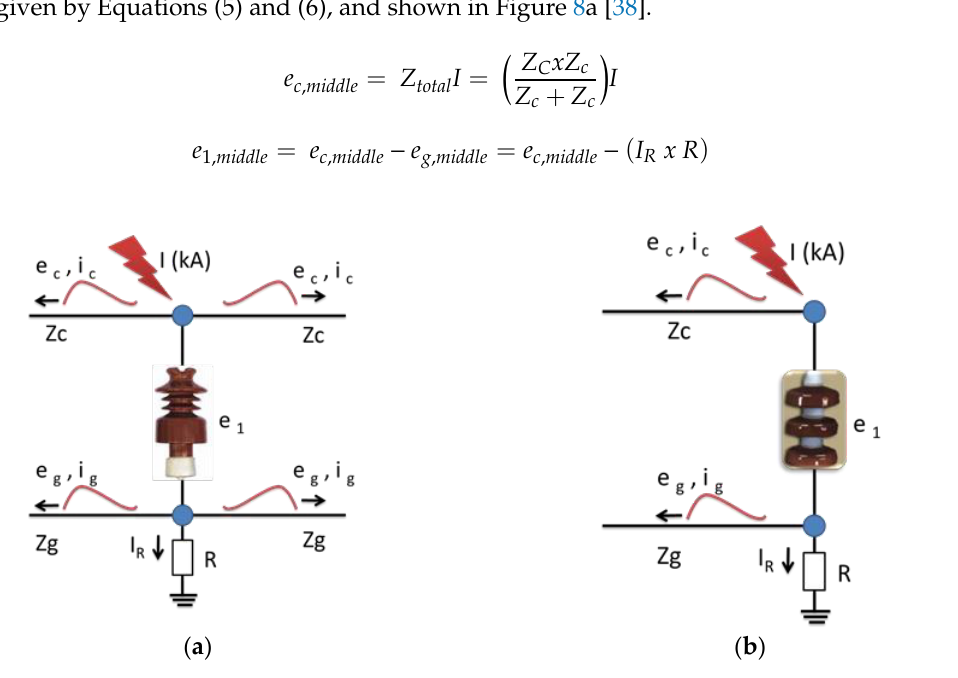
Figure 7. Result of a lightning strike to the phase conductor; ( a ) Strike to the phase conductor (middle); ( b ) Strike to the phase conductor (end).